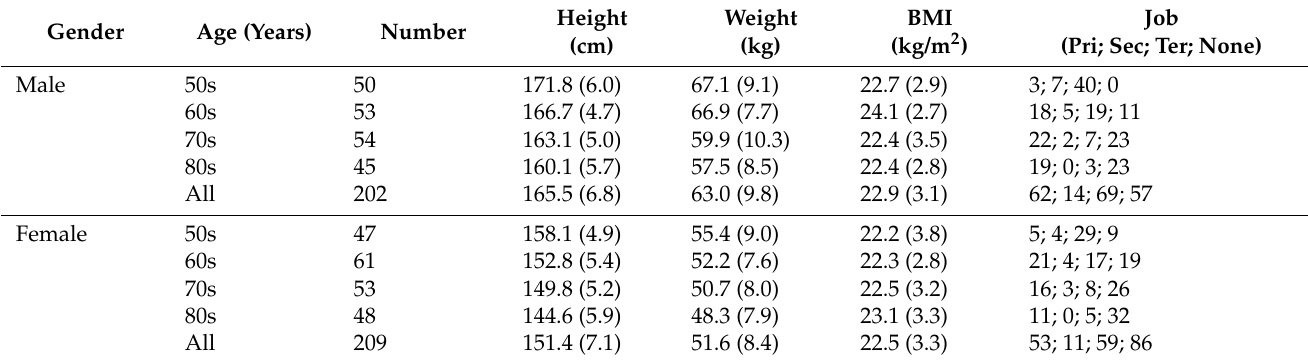
Table 1. Baseline characteristics of the study